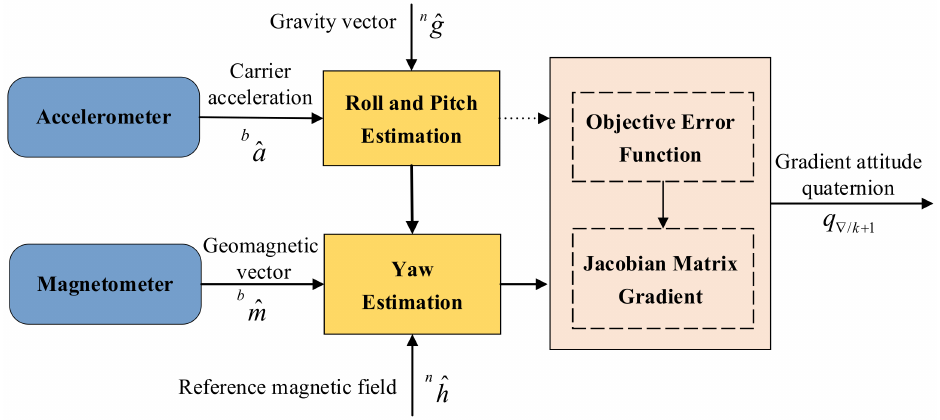
Figure 3. Schematic diagram of gradient descent